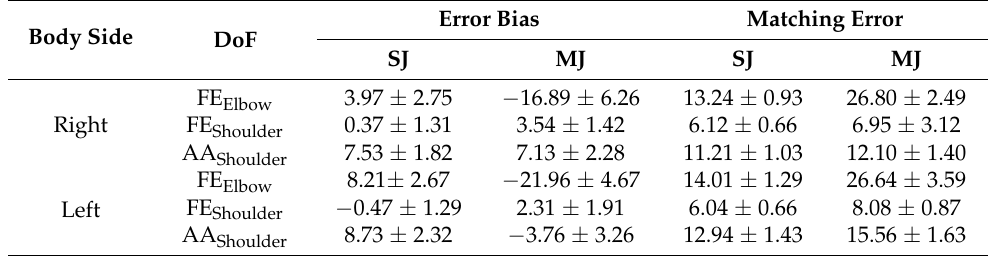
Table 1. Mean values and standard errors (%) for the Error Bias and Matching Error.